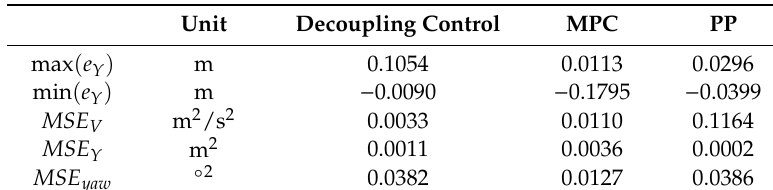
Table 1. The tracking performance statistics.